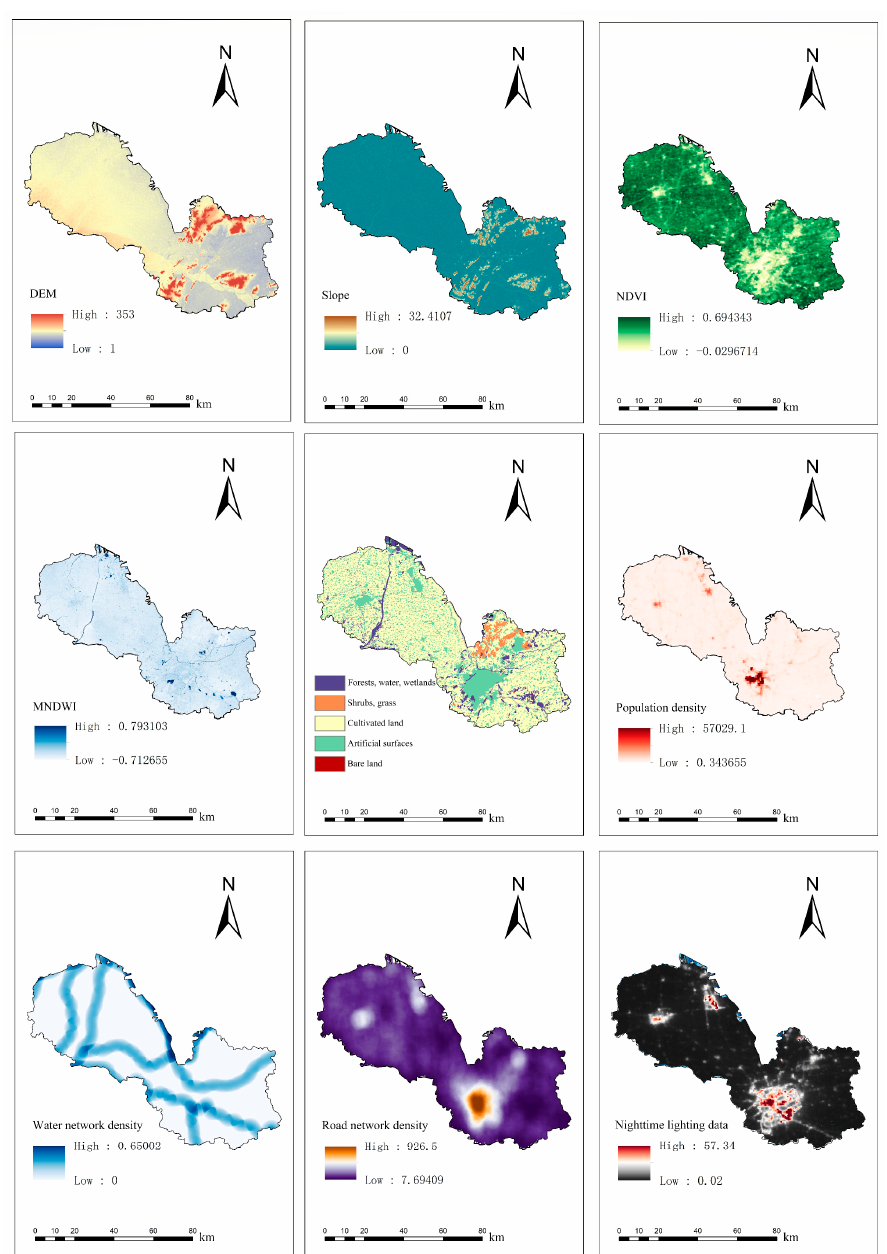
Figure 2. Elements of ecological spatial networks constructed based on datasets.